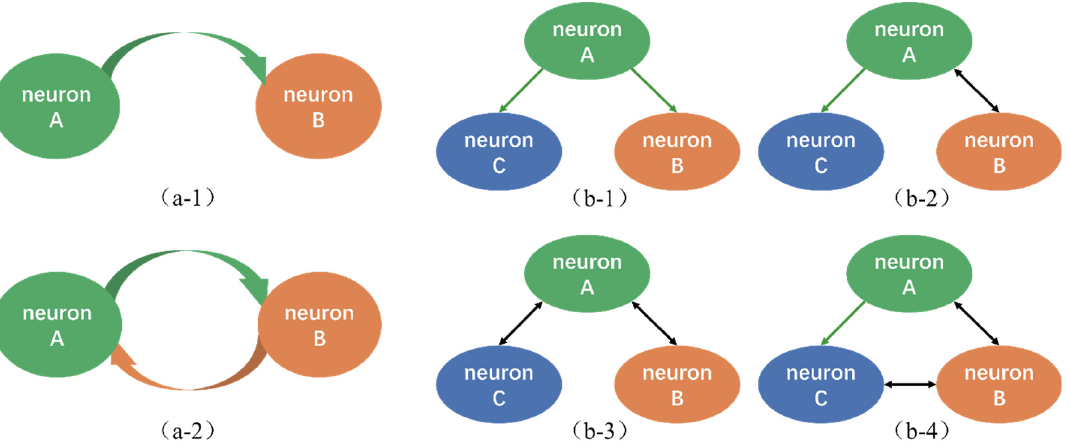
Figure 1 . Schematic diagram of motif model connection (a-1: Unidirectional coupling of neurons A and B. a-2: Dual coupling of neurons A and B. b-1: Unidirectional coupling of neurons A and B, and B. ( a-2 ): Dual coupling of neurons A and B. ( b-1 ): Unidirectional coupling of neurons A and B, Unidirectional coupling of neurons A and C. b-2: Dual coupling of neurons A and B, Unidirec- Unidirectional coupling of neurons A and C. ( b-2 ): Dual coupling of neurons A and B, Unidirectional tional coupling of neurons A and C. b-3: Dual coupling of neurons A and B, Dual coupling of neu- coupling of neurons A and C. ( b-3 ): Dual coupling of neurons A and B, Dual coupling of neurons A rons A and C. b-4: Dual coupling of neurons A and B, Unidirectional coupling of neurons A and and C. ( b-4 ): Dual coupling of neurons A and B, Unidirectional coupling of neurons A and C, Dual C, Dual coupling of neurons B and C.). coupling of neurons B and